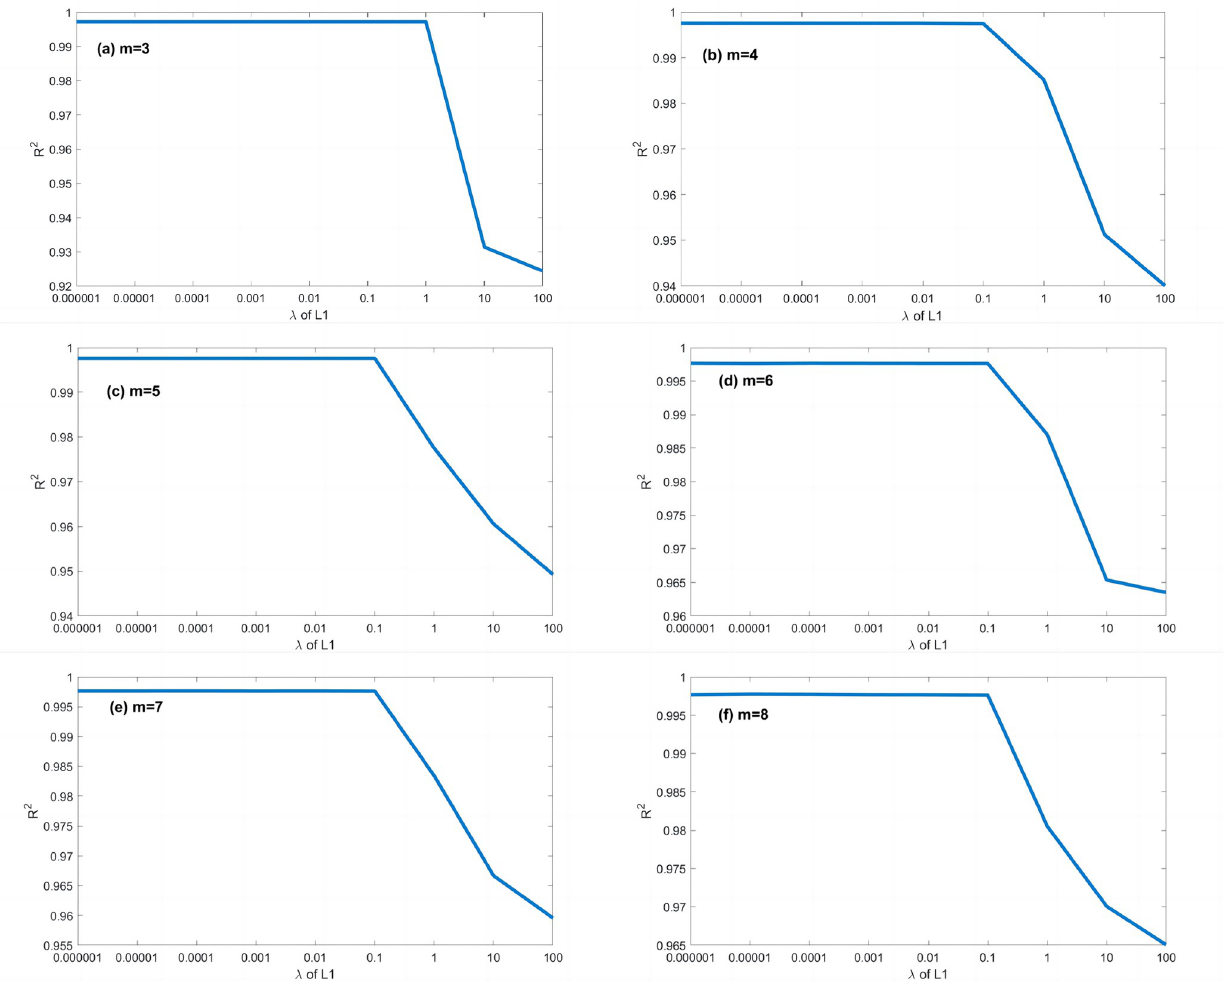
Fig 3. Comparison of EPR results (R 2 ) for different values of λ to L1RM (dataset 1). (a) m = 3, (b) m = 4, (c) m = 5, (d) m = 6, (e) m = 7 and (f) m = 8.